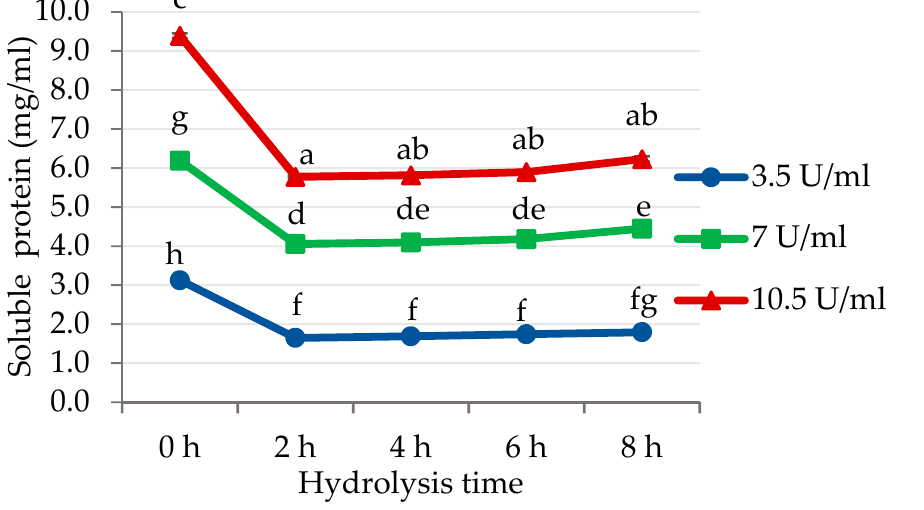
Figure 2. Soluble protein in the buffer–enzyme solution during hydrolysis with bromelain. a–h non- capital letters represent the statistical differences ( p <0.05).